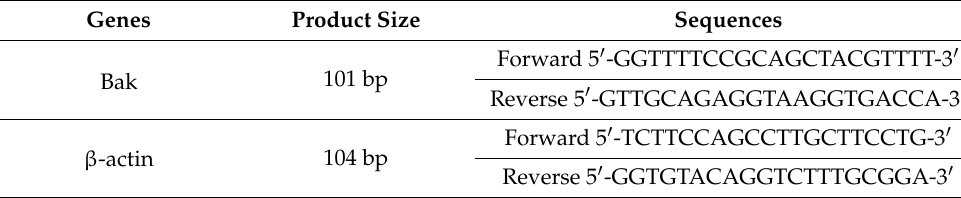
Table 1. Cont. Genes Product Size